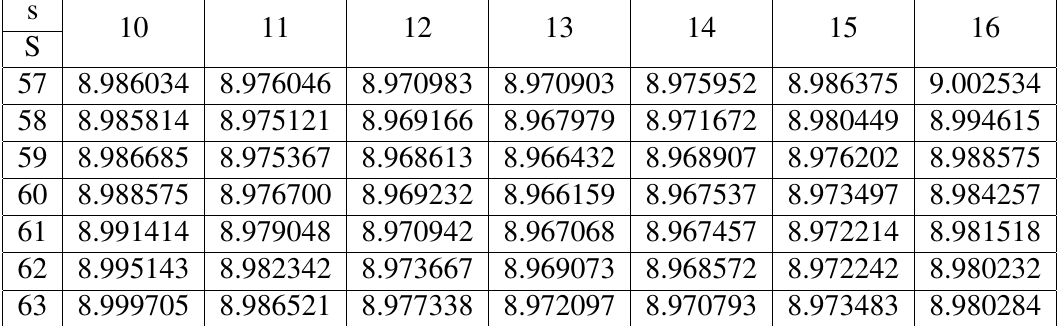
Table 2: TCV for the case of non-SDAP and